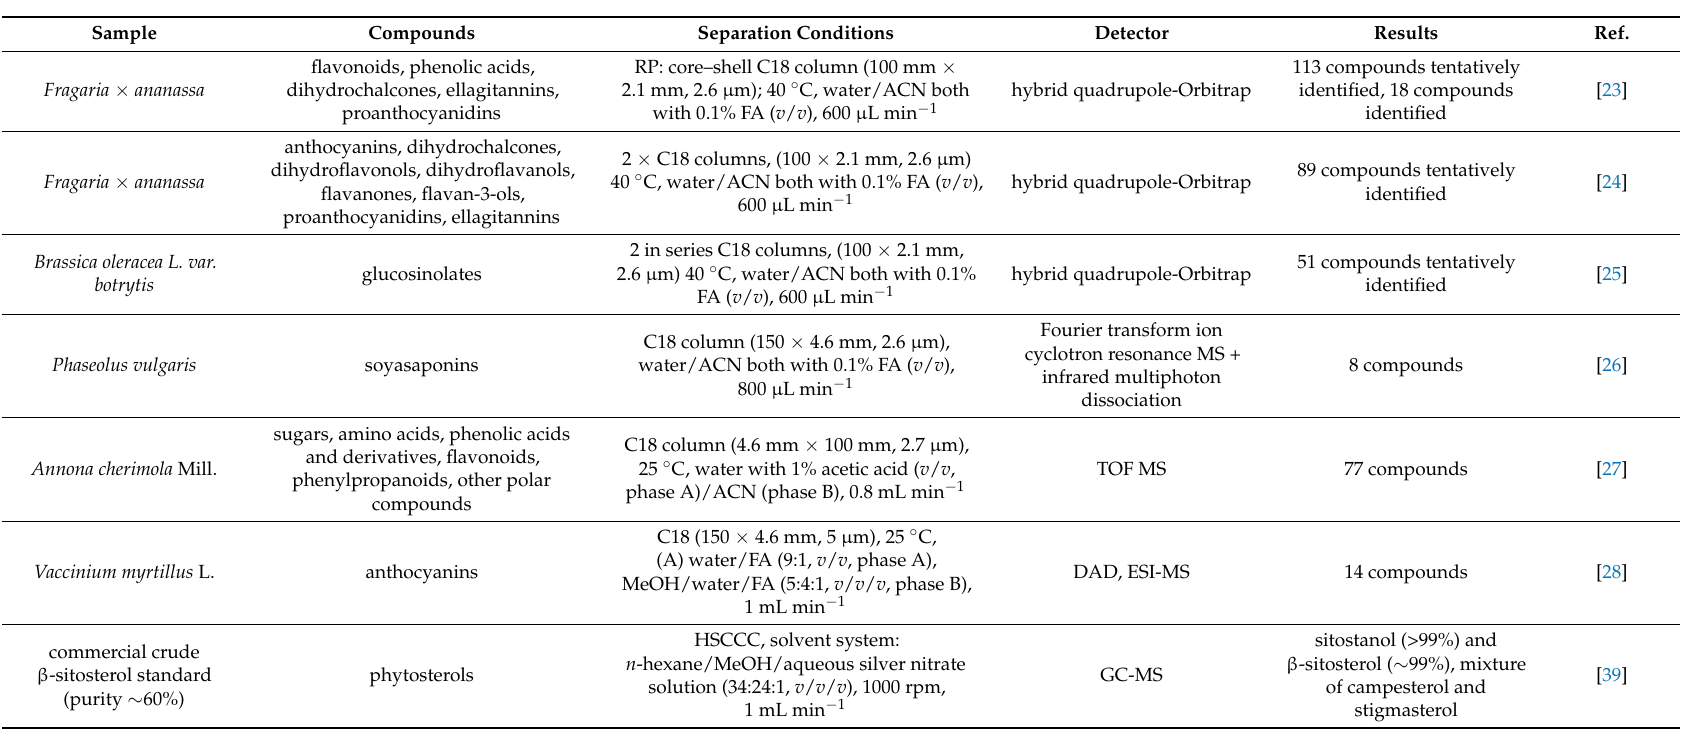
Table 1. List of bioactive compounds with related natural source, separation conditions, and detection used in the research papers discussed in the mini review. For comparative works, only the best conditions were reported. The following abbreviations were used: acetonitrile (ACN); angiotensin-converting enzyme (ACE); formic acid (FA); high-speed counter-current chromatography (HSCCC); matrix-assisted laser desorption ionization (MALDI); methanol (MeOH); “Sure